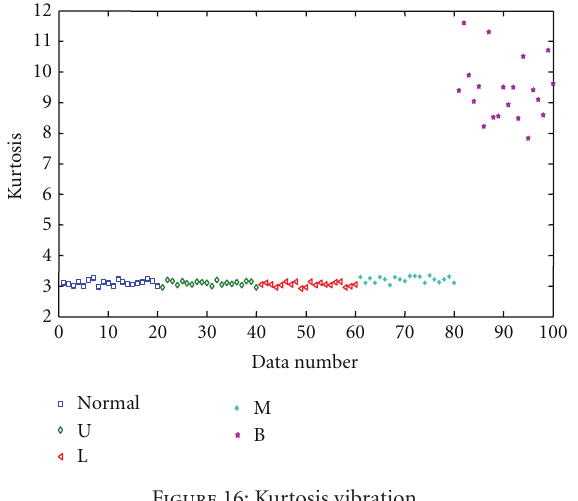
Figure 16: Kurtosis vibration.